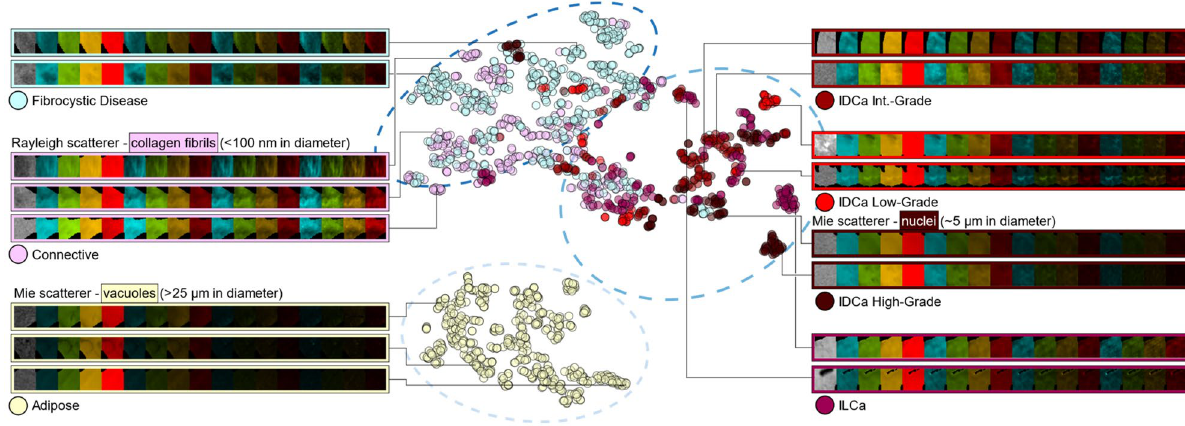
Figure 4. T-distributed stochastic neighbor embedding using six optimal MRMR radiomic/optomic features (i.e., top features shown in Fig. 3b). Dashed ellipses qualitatively delineate three clusters of samples, which can be related to hierarchical clusters depicted in Supplementary Material Fig. S2. Image channel labels show the micro-CT sub-image on the left (grayscale), followed by calibrated reflectance optical channels with spatial frequency increasing from left to right (0.00, 0.15, 0.61, then 1.37 mm −1 ). Coloring of optical channels illustrates the wavelength of light, increasing from left to right (490, 550, 600, then 700 nm) and repeated for each spatial frequency. IDCa = invasive ductal carcinoma. ILCa = invasive lobular